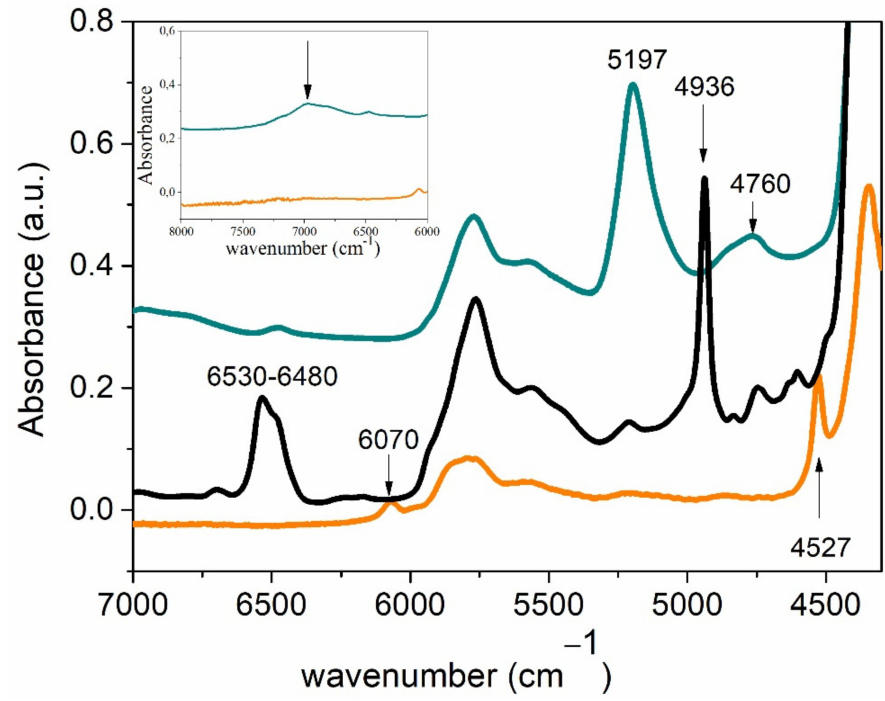
Figure 3. FT-NIR spectra of both monomers (PEGDE orange line, ED600 black line) and the product of polymerization after 24 h at 80 ◦ C (green line).